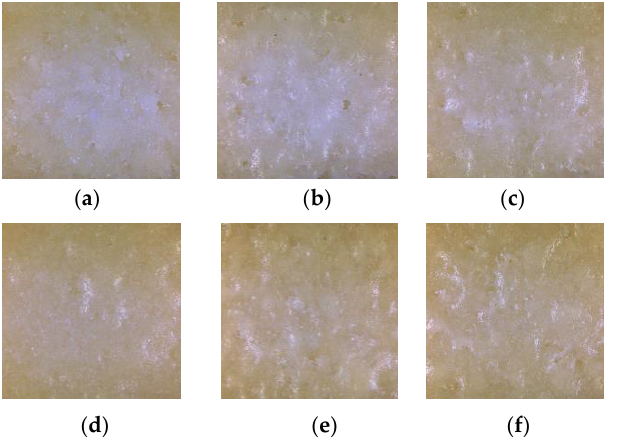
Figure 6. The surface of laser-sintered 10%-CPLA parts: ( a ) the green part; ( b ) 65 °C; ( c ) 100 °C; ( d ) 110 °C; ( e ) 120 °C; ( f ) 130 °C.